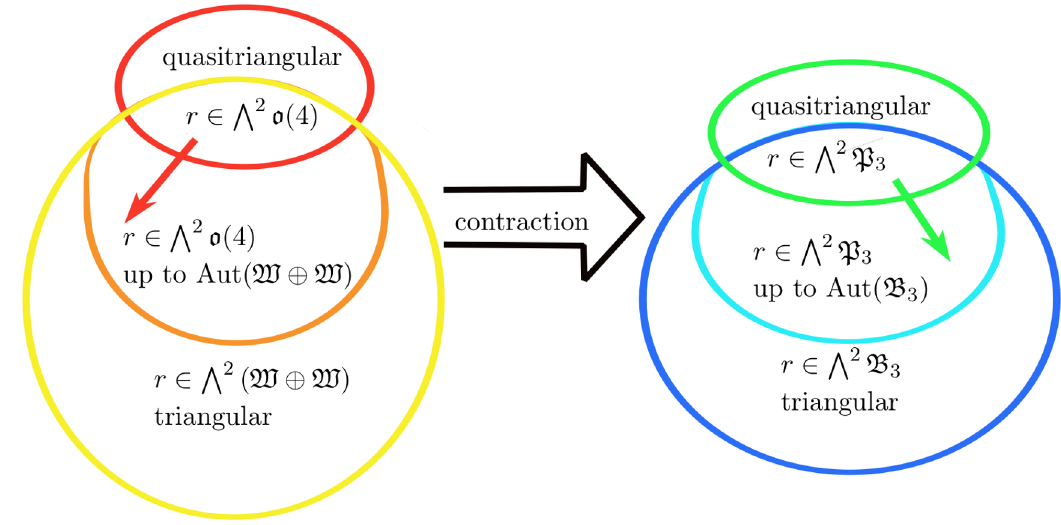
Figure 1 . Schematic depiction of r-matrices in three dimensional asymptotic symmetry al- gebras. The red arrow represents the quotient Aut ( o (4)) / Aut ( W ⊕ W ) and the green